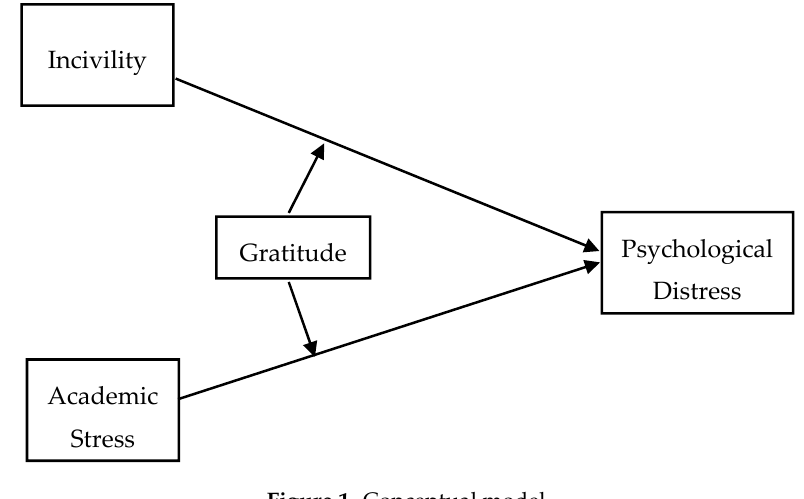
Figure 1. Conceptual model.